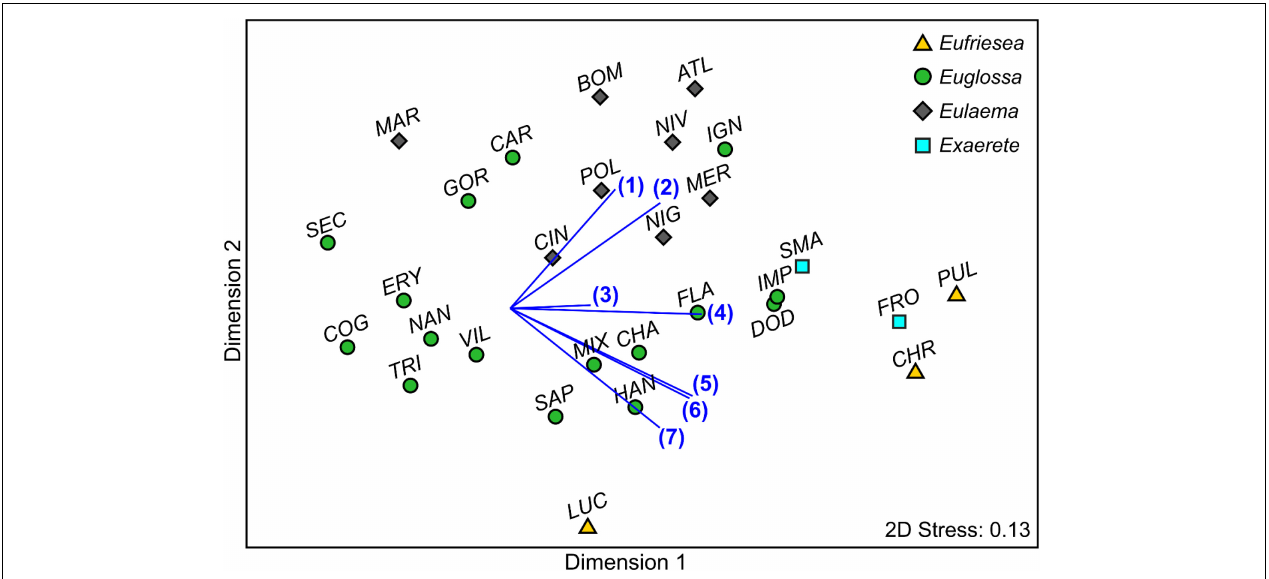
FIGURE 4 | Non-metric multidimensional scaling (nMDS) representation of mean antennal responses of different euglossine bees to 23 compounds, based on a Bray Curtis similarity matrix (standardized responses in percent). Vectors represent the Pearson correlations for compounds most responsible for the dissimilarity in antennal response profiles between species as indicated in a SIMPER analysis: (1) ( − )-( E )-carvone epoxide, (2) ipsdienol, (3) β -ionone, (4) α -pinene, (5) α -humulene, (6) α -copaene, (7) methyl o -anisate. Eg. carolina ( CAR ) , Eg. championi ( CHA ) , Eg. cognata ( COG ) , Eg. dodsoni ( DOD ) , Eg. erythrochlora ( ERY ) , Eg. flammea ( FLA ) , Eg. gorgonensis ( GOR ) , Eg. hansoni ( HAN ) , Eg. ignita ( IGN ) , Eg. imperialis ( IMP ) , Eg. mixta ( MIX ) , Eg. nanomelanotricha ( NAN ) , Eg. securigera ( SEC ) , Eg. sapphirina ( SAP ) , Eg. tridentata ( TRI ) , Eg. villosiventris ( VIL ) , Ef. chrysopyga ( CRY ) , Ef. lucifera ( LUC ) , Ef. pulchra ( PUL ) , El. atleticana ( ATL ) , El. bombiformis ( BOM ) , El. cingulata ( CIN ) , El. marcii ( MAR ) , El. meriana ( MER ) , El. nigrita ( NIG ) , El. niveofasciata ( NIV ) , El. polychroma ( POL ) , Ex. frontalis ( FRO ), and Ex. smaragdina ( SMA